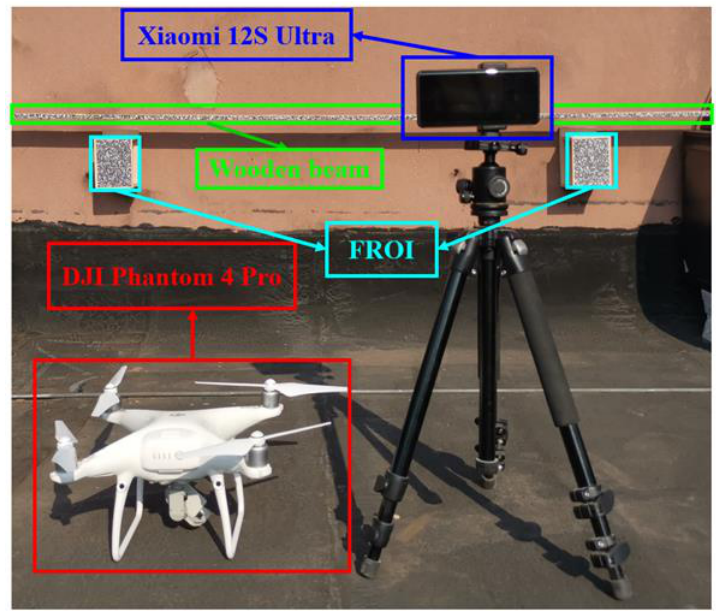
Figure 12. Experiment setting.